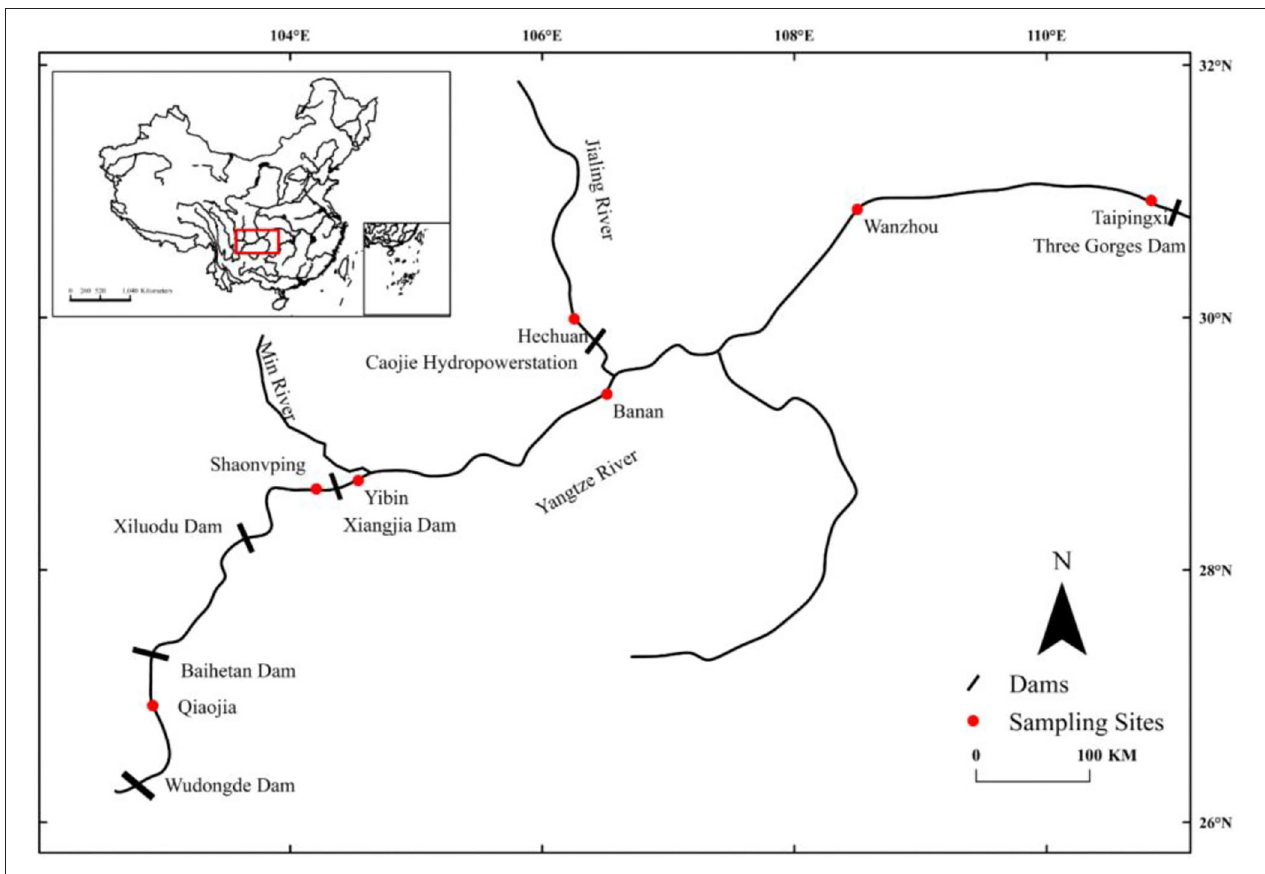
FIGURE 1 | Sampling sites in the upper Yangtze